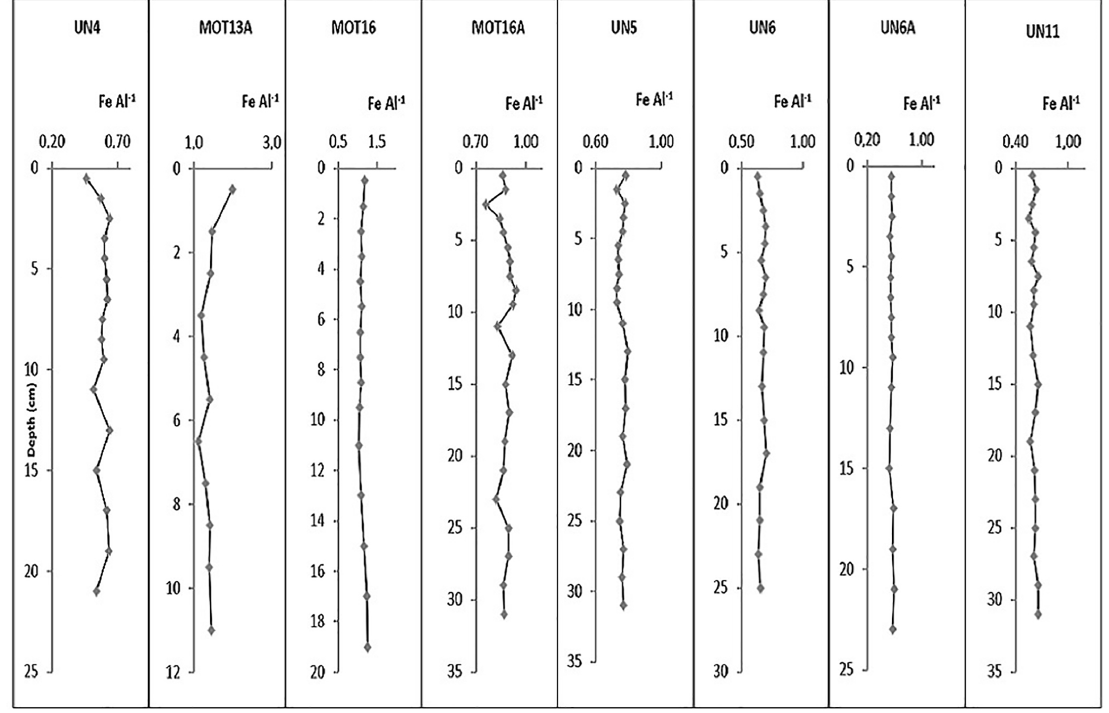
Figure A7. Vertical distributions of Fe Al − 1 in sediment cores. The ratios in the coarse cores MOT13A, MOT16 and UN4 are calculated at the fine-sediment fraction ( < 63µm).